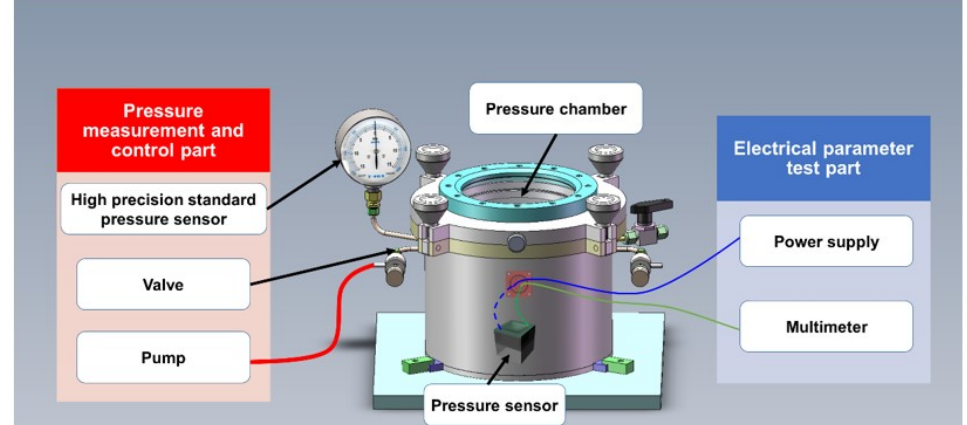
Figure 2. Diagram of the pressure sensor measurement